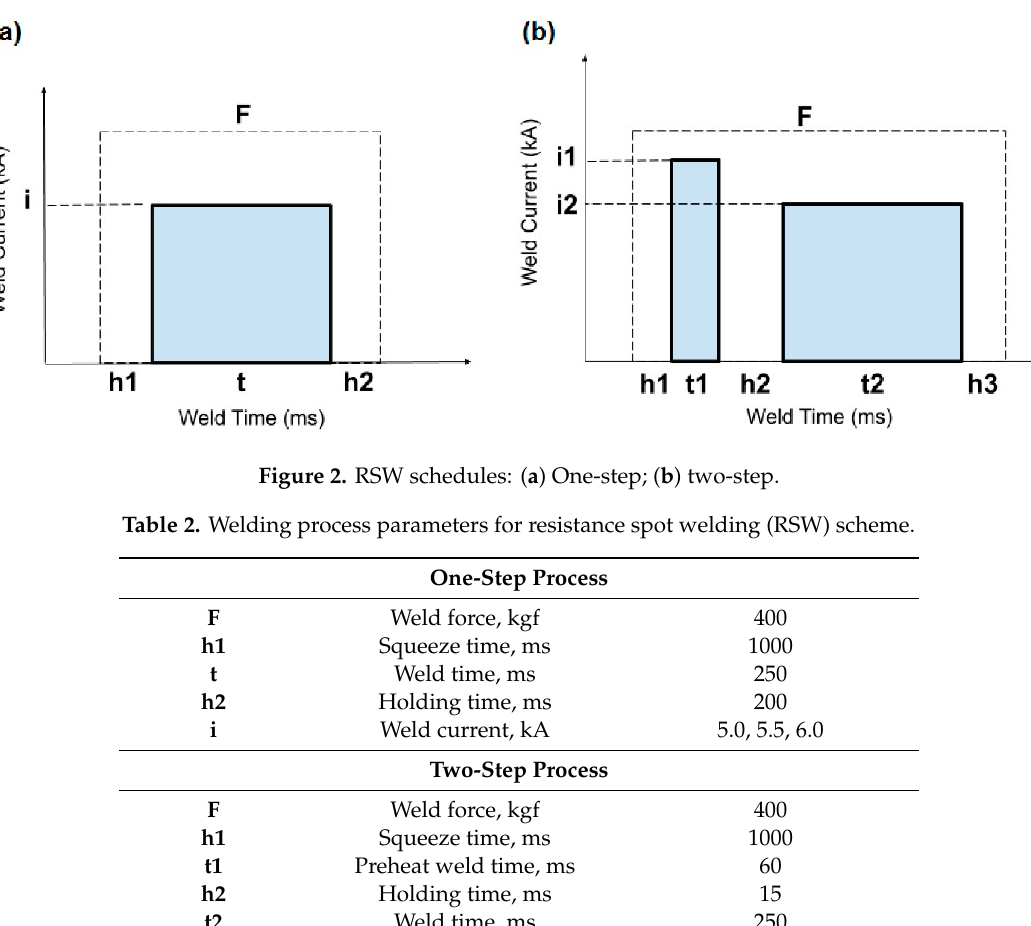
Figure 1. Welding current range of 15B22.